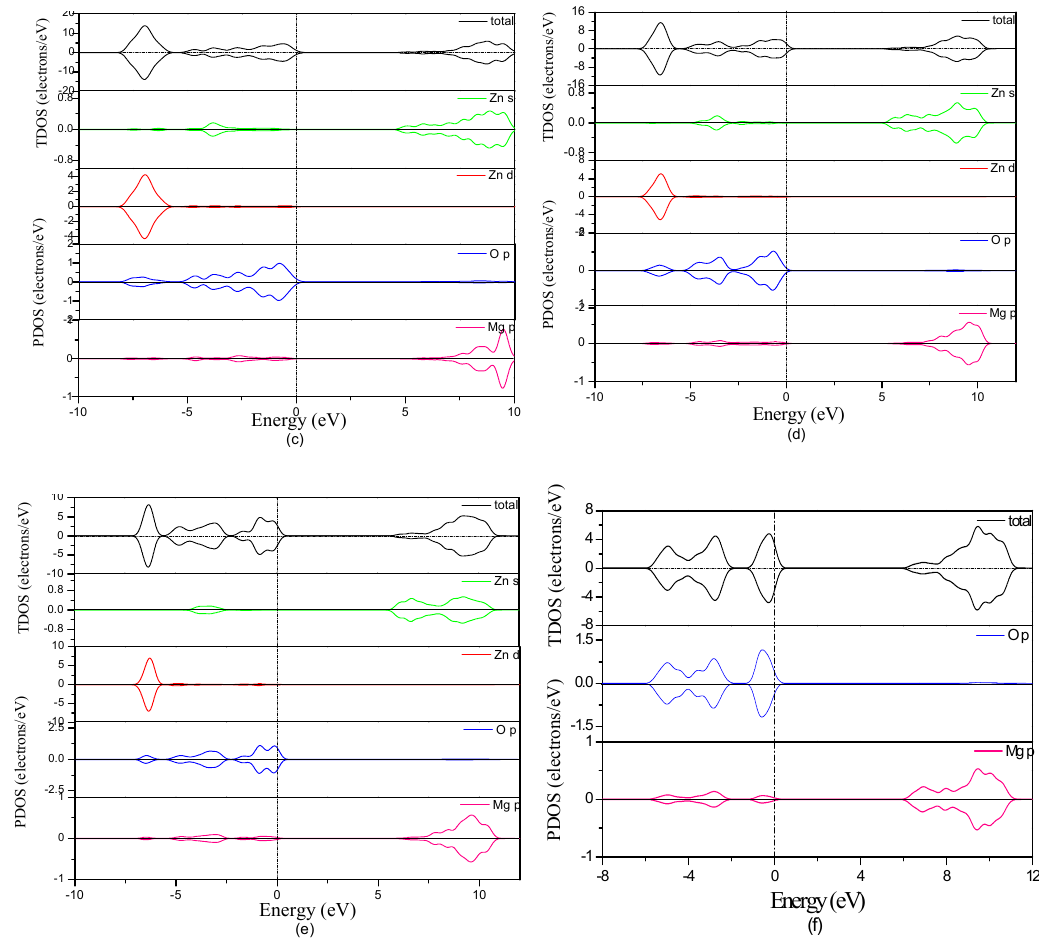
Figure 5. The total and partial DOS of Mg x Zn 1 − x O monolayer ( a ) x = 0.0625; ( b ) x = 0.125; ( c ) x = 0.25; ( d ) x = 0.5; ( e ) x = 0.75; ( f ) x = 1.